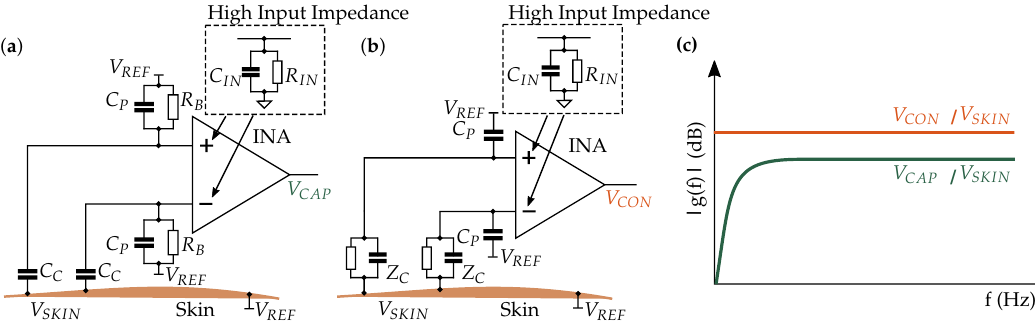
Figure 1. Comparison of the capacitive and conductive measurement principles. ( a ) Capacitive measurement: The coupling capacity C C forms a voltage divider with the parasitic capacity C P and the bias resistor R B , which is necessary for the bias current. ( b ) Conductive measurement: The high input impedance of the amplifiers can be exploited, because no bias resistor is required. Z C is the coupling impedance. ( c ) Transfer functions of the measurement